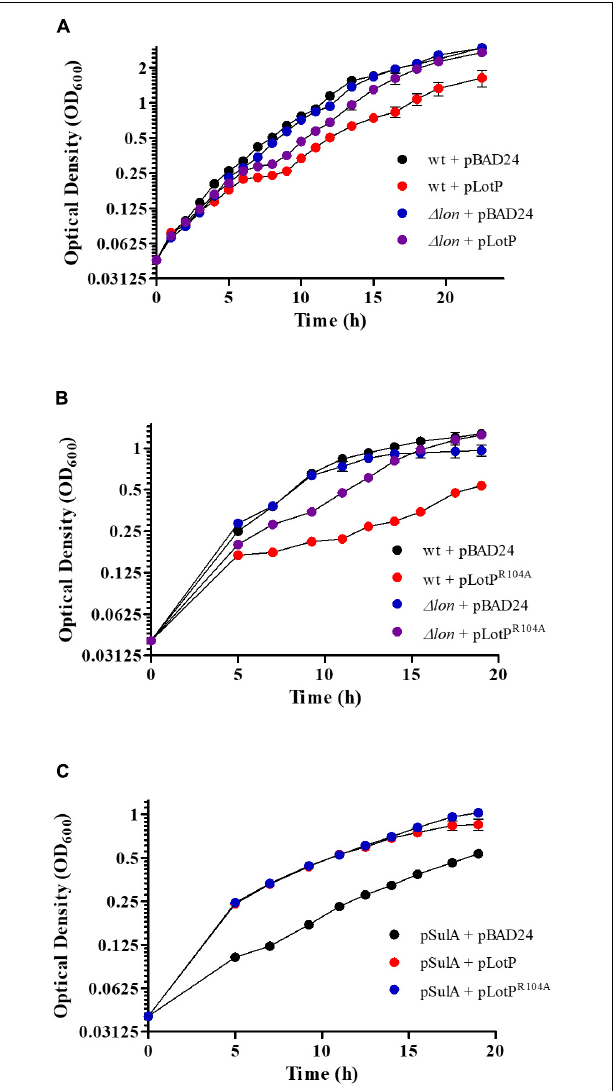
FIGURE 7 | Effect of LotP on the growth of Escherichia coli wild type (wt) and (cid:49) lon . Growth curves of wt and (cid:49) lon E. coli overexpressing LotP constructs LotP and LotP R104A . Strains transformed with the pBAD24 vector were used as a control. Growth curve data represent averages ± SD ( n = 3). (A) wt + pBAD24 (black), wt + pLotP (red), (cid:49) lon + pBAD24 (blue), and (cid:49) lon + pLotP (purple). (B) wt + pBAD24 (black), wt + pLotP R104A (red), (cid:49) lon + pBAD24 (blue), and (cid:49) lon + pLotP R104A (purple). Cultures were grown in M9 media with the addition of Ca 2 + , Mg 2 + , and glycerol; 0.2% L -arabinose was added for pBAD24 induction. (C) Growth curves of wt E. coli overexpressing SulA, LotP, and LotP R104A . Cultures were grown in M9 media with the addition of Ca 2 + , Mg 2 + , and glycerol. A low concentration of L -arabinose (0.001%) was added to induce the expression of pBAD24, and 100 µ M of IPTG was added for SulA expression. pSulA + pBAD24 (black), pSulA + pLotP (red), and pSulA + pLotP R104A (blue). Growth curve data represent averages ± SD ( n =